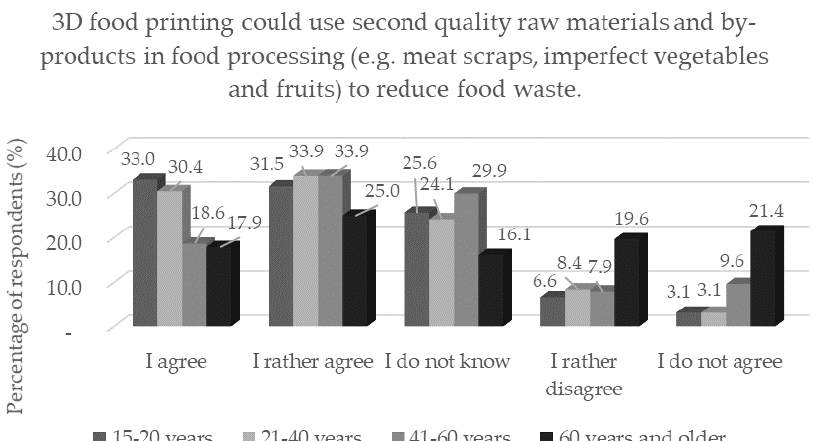
Figure 11. Respondents’ opinions on the application of 3D food printing by age category in response to the statement: “3D food printing could use second quality raw materials and by-products in food processing (e.g., meat scraps, imperfect vegetables and fruits) to reduce food waste.”